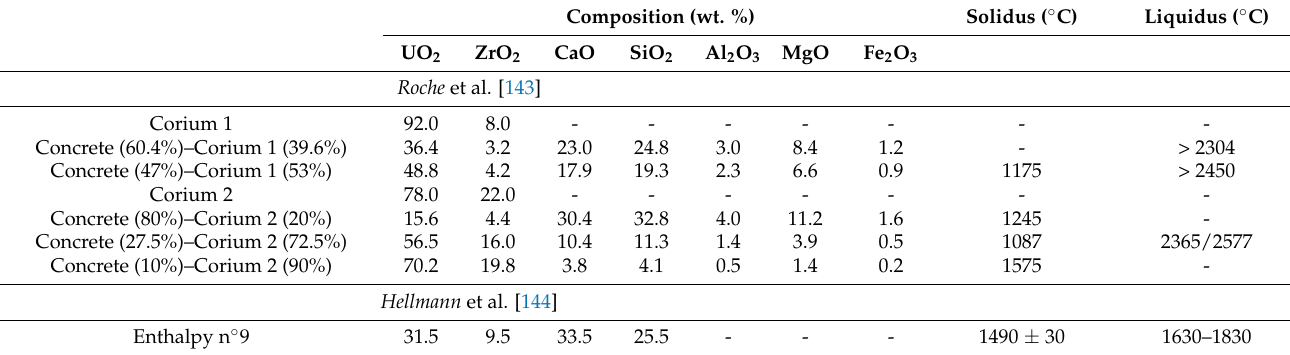
Table 6. Corium–“limestone common sand concrete” compositions and measured solidus and liquidus temperatures